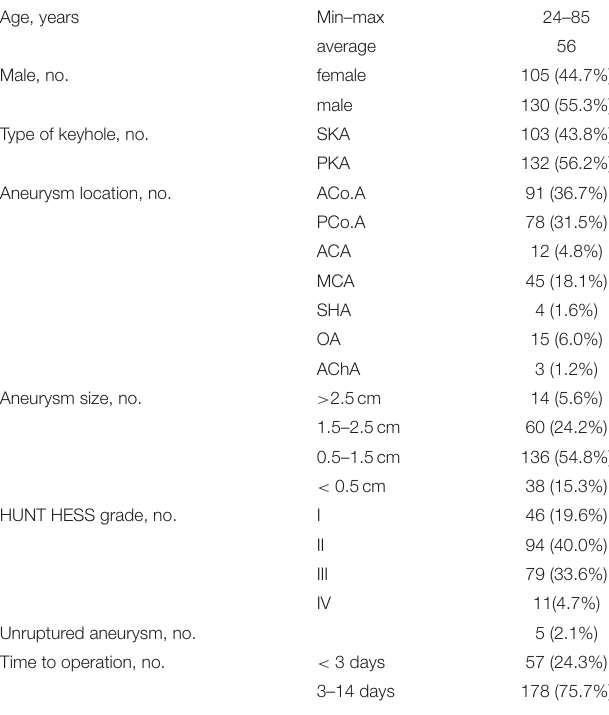
TABLE 1 | Baseline characteristics of